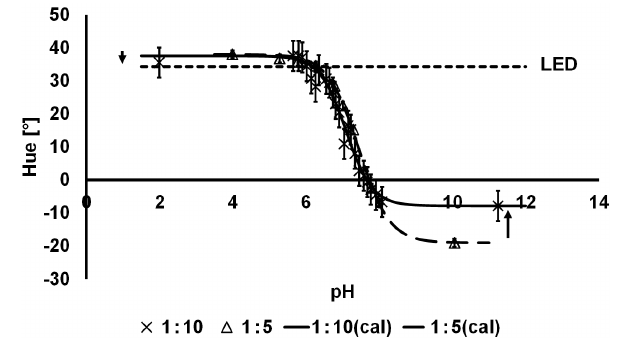
Figure 8. Direct comparison of the results of PhR:SPPB with ra- tios 1:10 and 1:5. Hue value of the LED and the probable influence of the LED on the results are indicated by the black arrow.